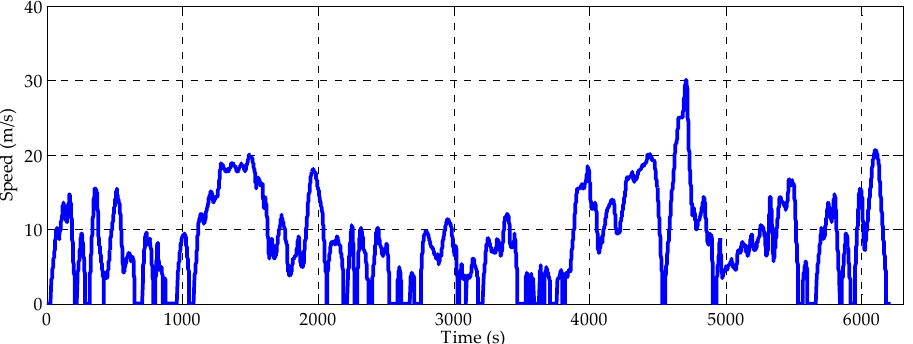
Figure 7. Constructing the driving cycle using the Markov process based on large quantity of recorded data.